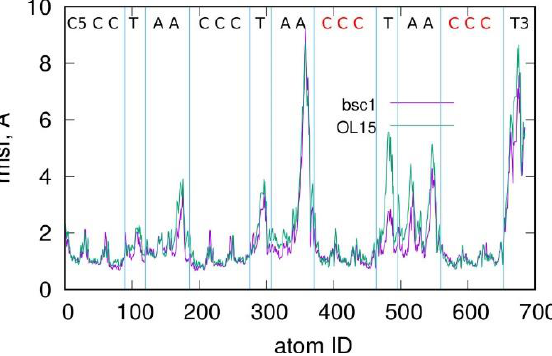
Figure 2. Root-mean-square fluctuation of atomic positions within the i-motif structure obtained for the studied parametrizations of the Amber force fields. The letters on the top show which residues the given atomic numbers belong to. The red C letters denote the protonated cytosines.